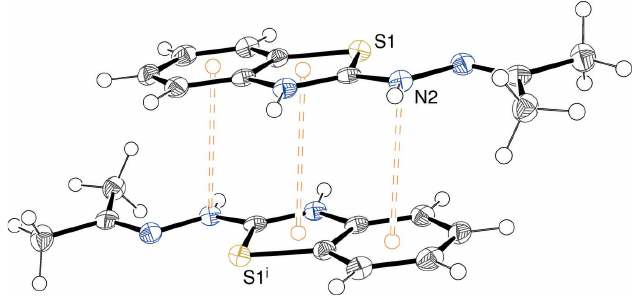
Figure 4 Detail of the extended structure of (I) showing (cid:2) – (cid:2) stacking between inversion-related thiazole rings and possible secondary N (cid:2)(cid:2)(cid:2) (cid:2) inter- actions. Symmetry code: (i) (cid:3) x, 1 (cid:3) y, 1 (cid:3) z.